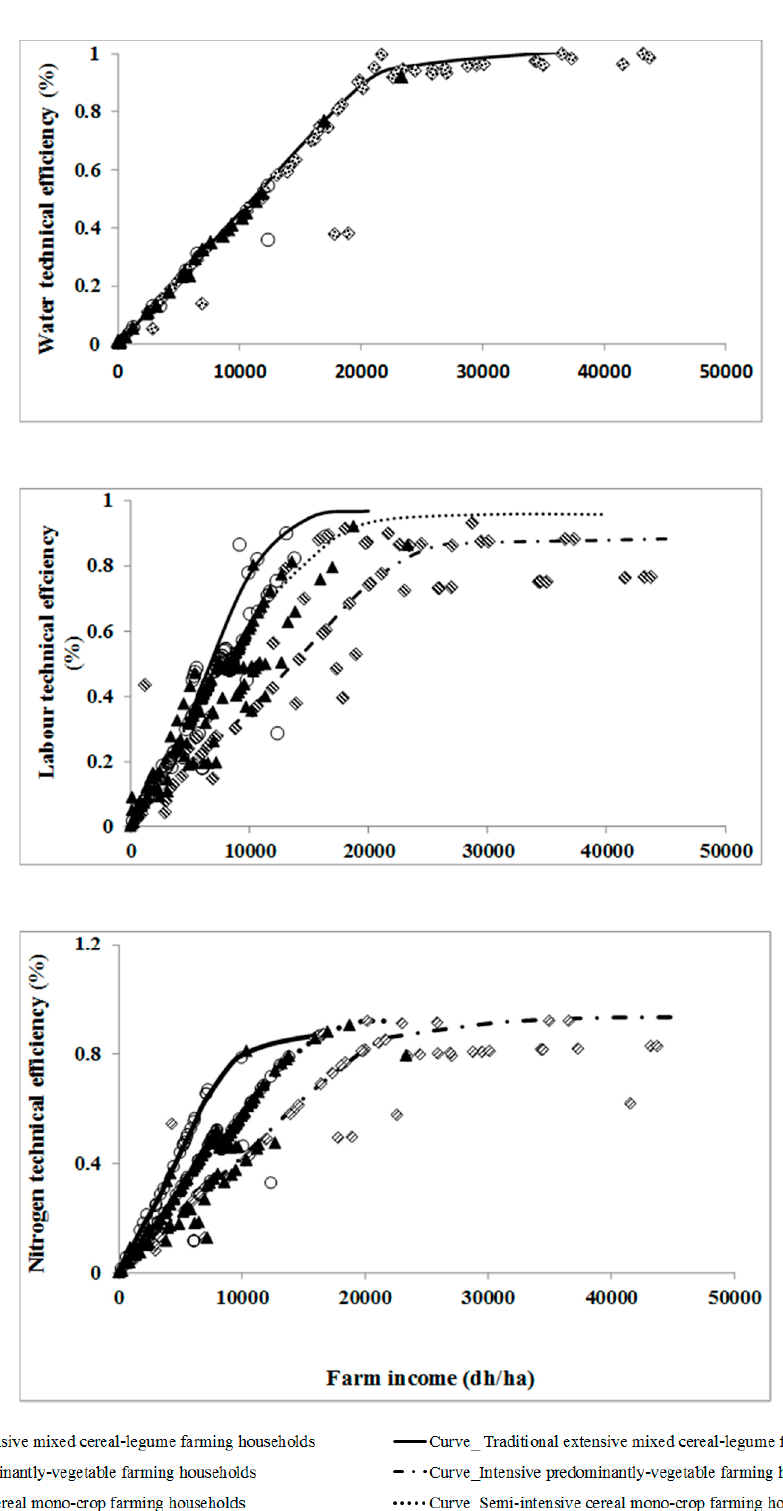
Figure 6. Envelope curves of the distribution of farm households according to input specific technical efficiencies.